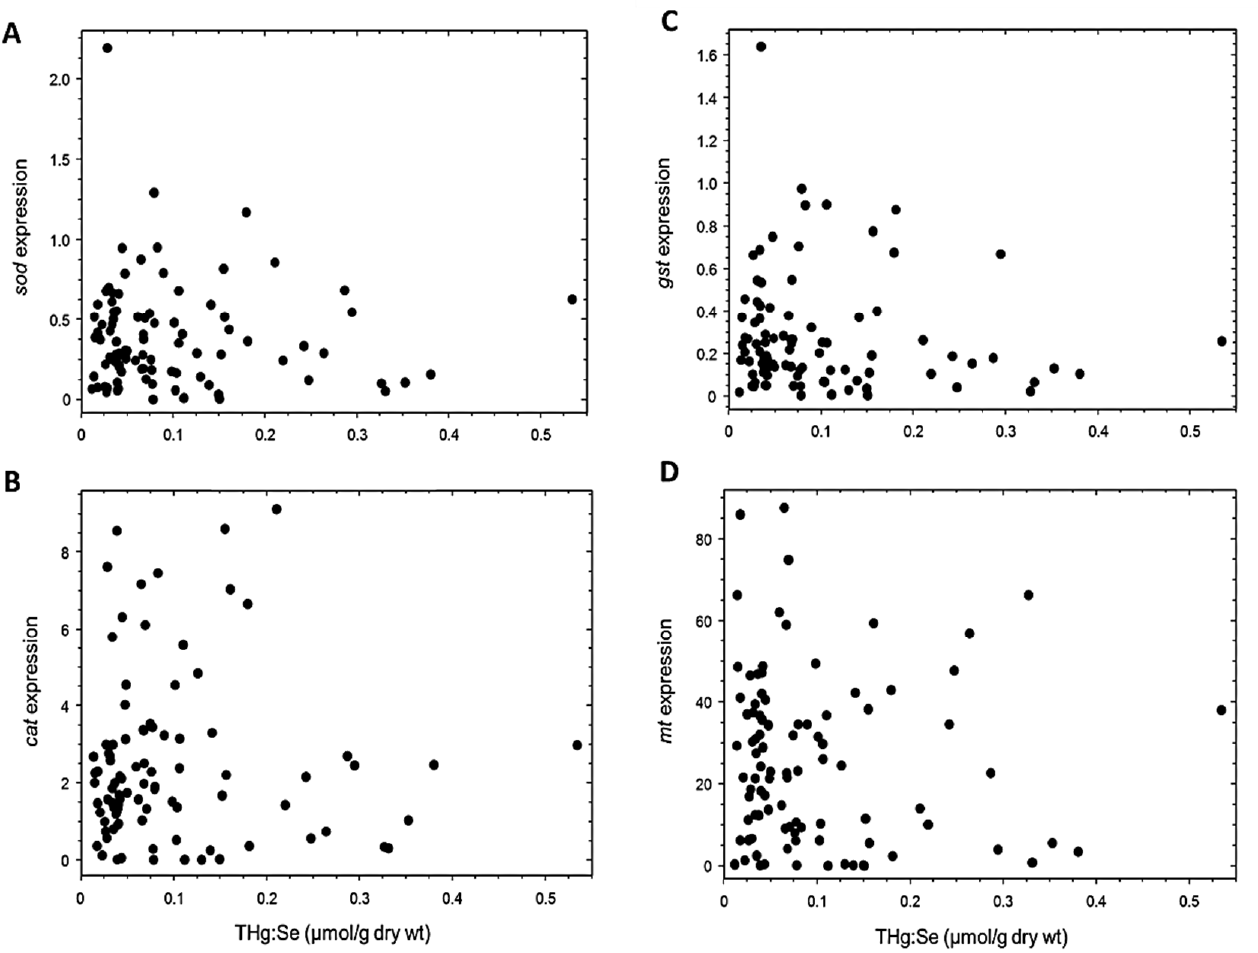
Figure 3. Quantile regression analysis between normalized ( A ) sod ( τ 99; p = 0.481; n = 94), ( B ) cat ( τ 99; p = 0.255; n = 92), ( C ) gst ( τ 99; p = 0.524; n = 94), and ( D ) mt ( τ 99; p = 0.741; n = 94) expression and molar ratio of total mercury to selenium (THg:Se) in livers of northern pike. Metallothionein expression did not change significantly with increasing MeHg:Se ( τ 80, p = 0.723), IHg:Se ( τ 90, p = 0.183), or THg:Se ( τ 99, p = 0.741; Figure 3) molar ratios, and was not significantly altered with an increasing percentage of MeHg ( τ 95, p = 0.268). Metallothionein expression was significantly related to Se ( µ mol/g dry wt) ( τ 95, p =